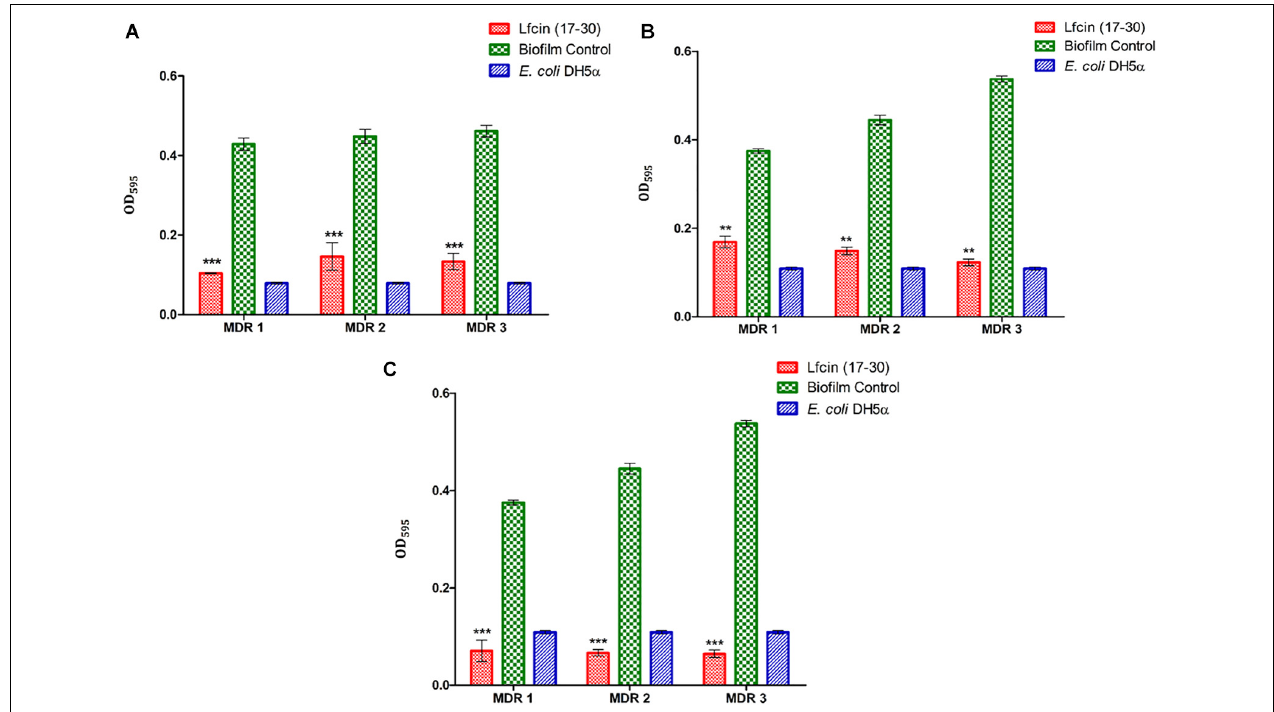
FIGURE 4 | Inhibition and eradication of MDR-EAEC biofilm by Lfcin (17–30) by CV staining. Inhibition of MDR-EAEC biofilm by Lfcin (17–30) at 24 h (A) , 48 h (B) , and effect of treating MDR-EAEC preformed biofilms (48 h) with Lfcin (17–30) for an additional 24 h (C) by CV staining. Error bars indicate the standard deviation between strains. Control bars indicate corresponding MDR-EAEC strains (biofilm control) and E. coli DH5 α biofilms, respectively, without AMP (*** P < 0.001; ** P <